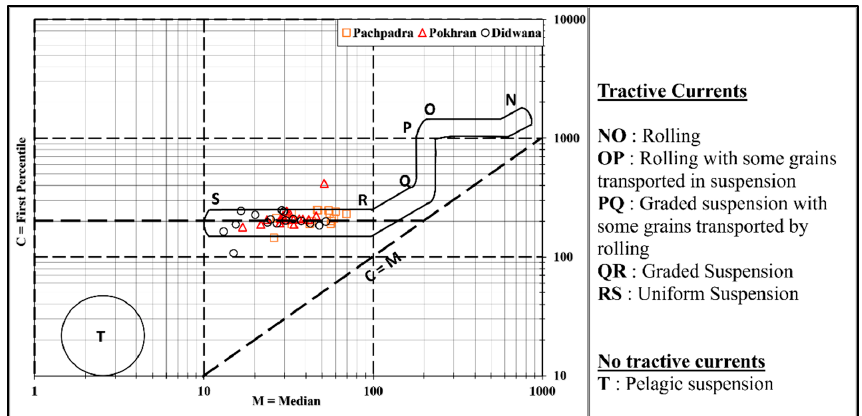
Figure 7. Sediment transport and deposition process (CM) diagram of Pachpadra, Pokhran, and Didwana playas. (adapted from Passega, 1957 and Passega and Byramjee, 1969).